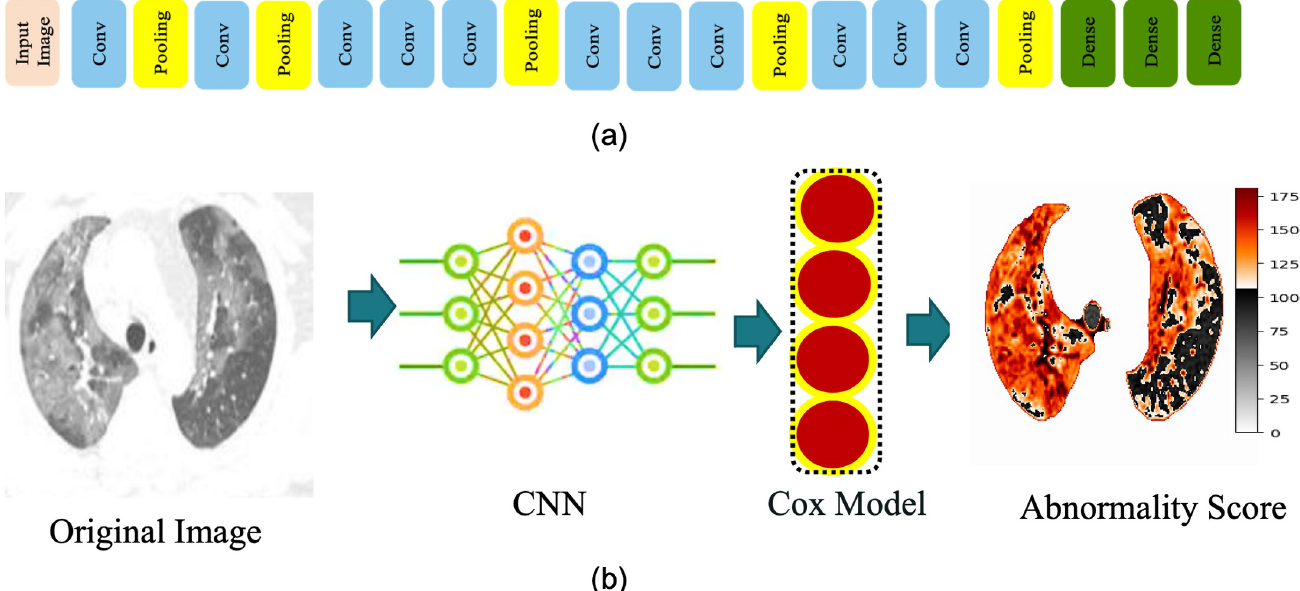
Fig 5. (a) The architecture of the CNN for abnormality prediction. We used the segmented lungs and GGOs as input images (described in section 3.1). (b) Workflow diagram for abnormality prediction. We used the CNN architecture mentioned in Fig 5A. The output of the CNN network was fed to the Cox model to compute abnormality. The output of abnormality scores is represented by a heatmap. Orange to red color denotes high-abnormality regions.